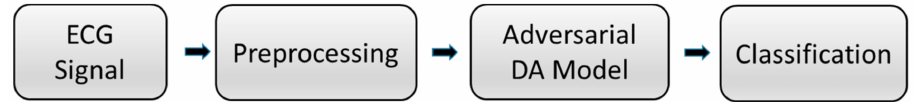
Figure 1. Flowchart of the proposed system. ECG: electrocardiogram. DA: domain